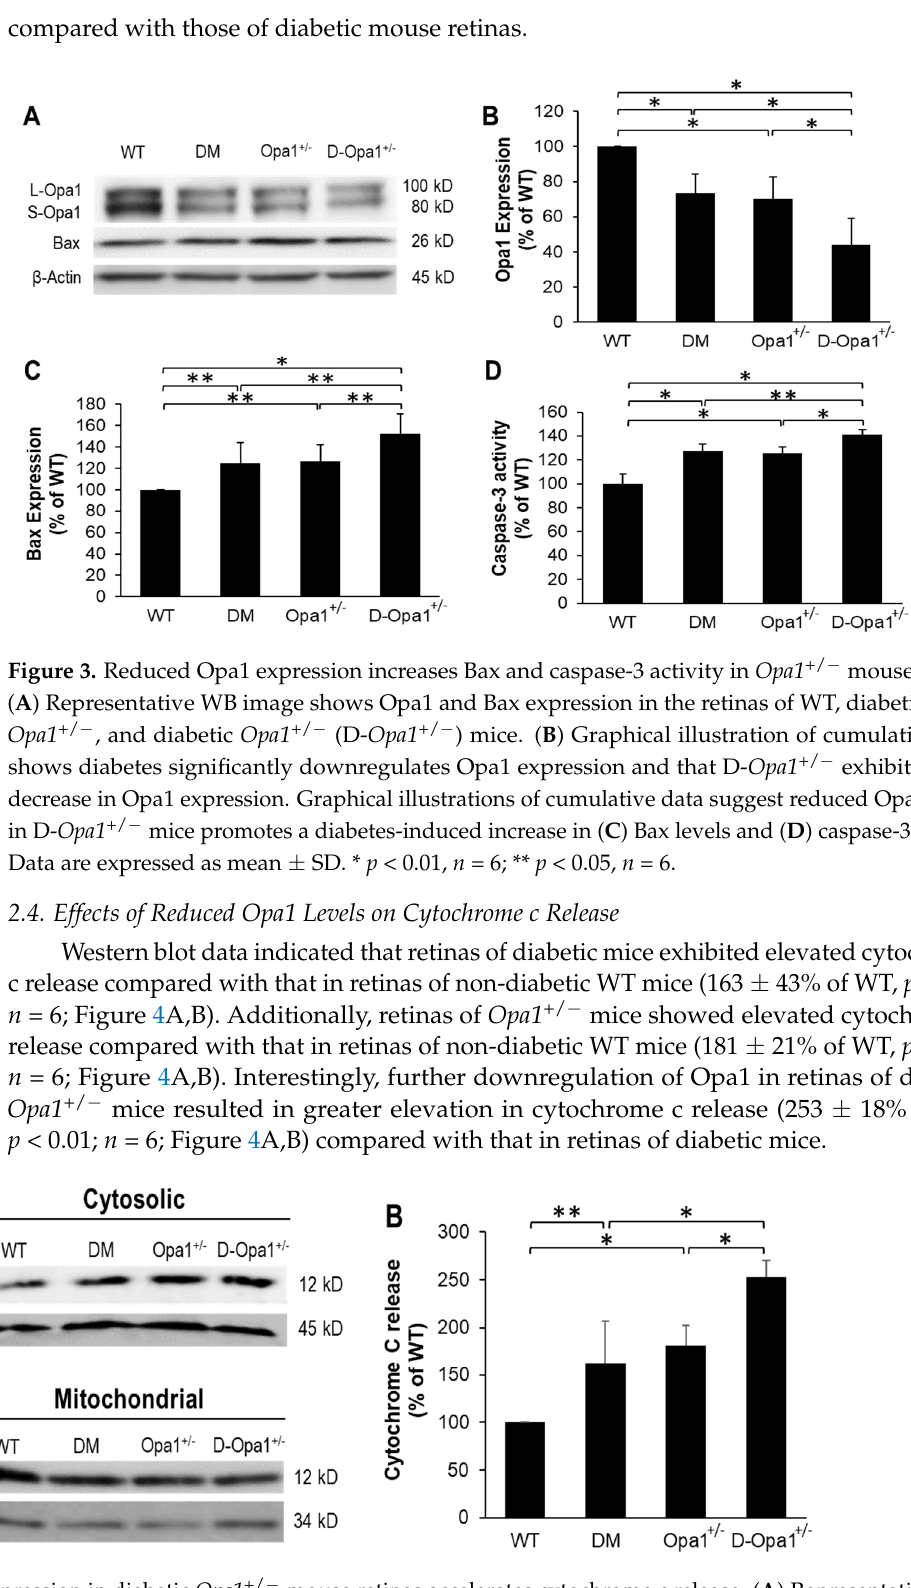
Figure 4. Reduced Opa1 expression in diabetic Opa1 +/ − mouse retinas accelerates cytochrome c release. ( A ) Representative WB image shows cytochrome c levels in cytosolic and mitochondrial fractions in retinas of WT, diabetic (DM), Opa1 +/ − , and diabetic Opa1 +/ − (D- Opa1 +/ − ) mice. ( B ) Graphical illustration of cumulative data shows diabetes and reduced Opa1 level significantly upregulate cytochrome c release, and that further reduction in Opa1 expression in retinas of D- Opa1 +/ − mice results in greater elevation in cytochrome c release. Data are expressed as mean ± SD. * p < 0.01, n = 6; ** p < 0.05, n =